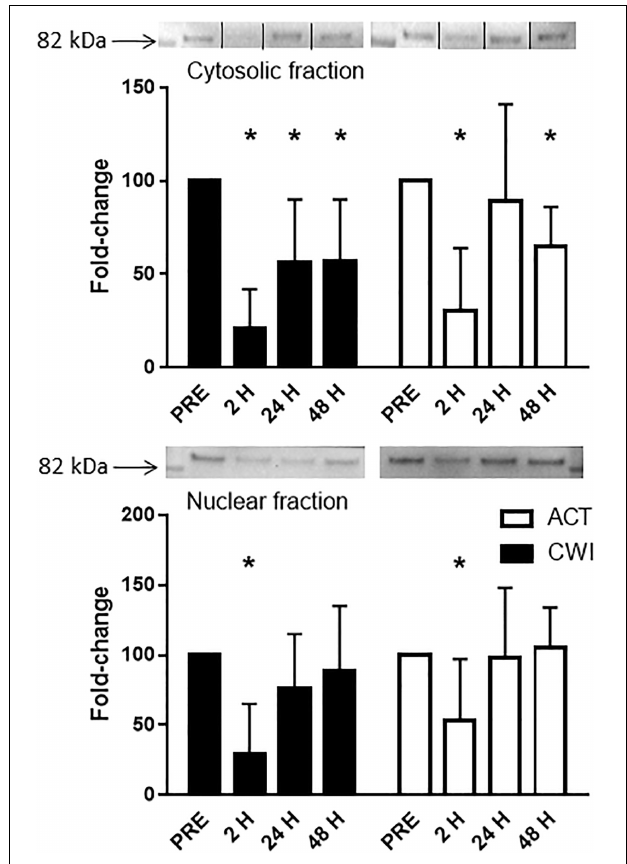
FIGURE 6 | Representative blots and data for expression of FoxO3a in the cytosolic fraction and nuclear fraction isolated from muscle tissue homogenates. Western blotting for FoxO3a in the cytosolic fraction was performed simultaneously on the same membrane for another protein (data published elsewhere (Peake et al., 2017). For the purpose of clarity here, the images for the blots have been cropped (indicated by the lines on the blot) to show only the blots for FoxO3a. Data are expressed as mean ± SD. * P < 0.05 versus pre-exercise. ACT, active recovery; CWI, cold water